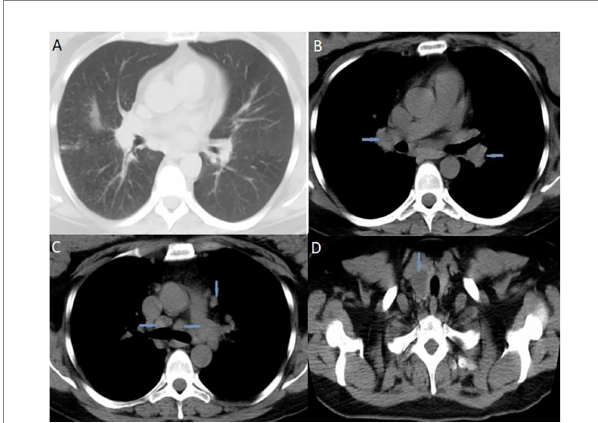
FIGURE 1 High-resolution computed tomography (HRCT) of the chest suggested pulmonary sarcoidosis: (A) micronodular lesions in pulmonary parenchyma; (B) hilar lymphadenopathy (blue arrows); (C) mediastinal lymphadenopathy (blue arrows). CT scans of the neck (D) indicated nodular mass inside the right thyroid lobe (blue arrow). HRCT, high-resolution computed tomography; CT, computed tomography.